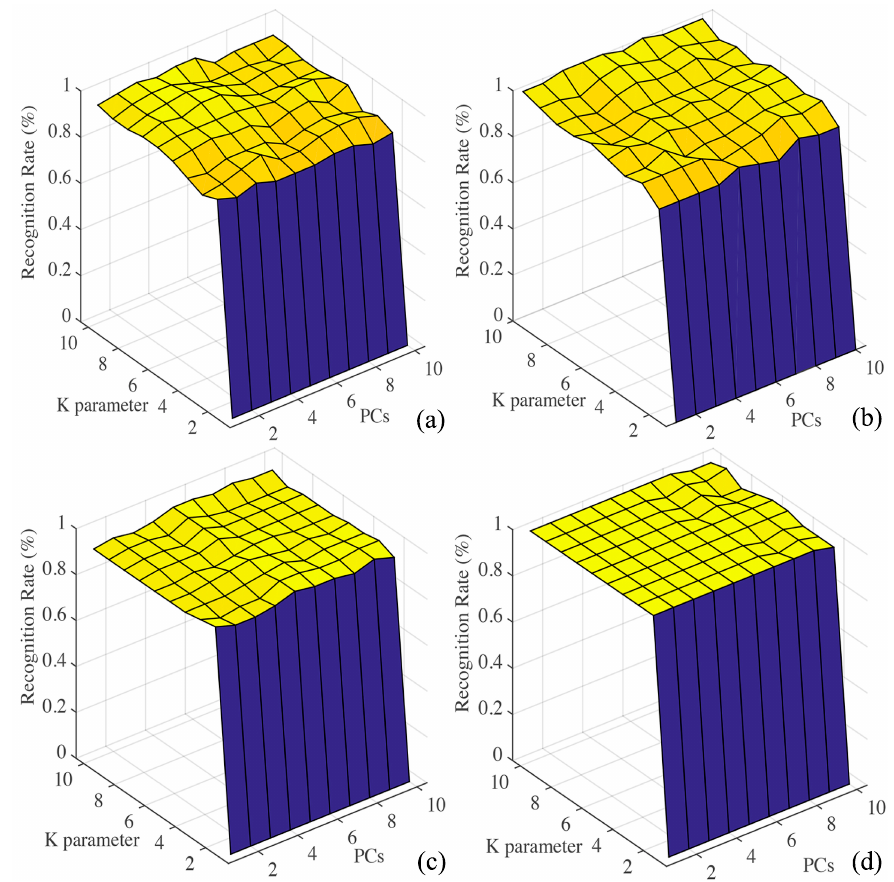
Figure 5. ( a , b ) K-nearest neighbor (KNN) results using data from all sensors; ( c , d ) feature sensors.